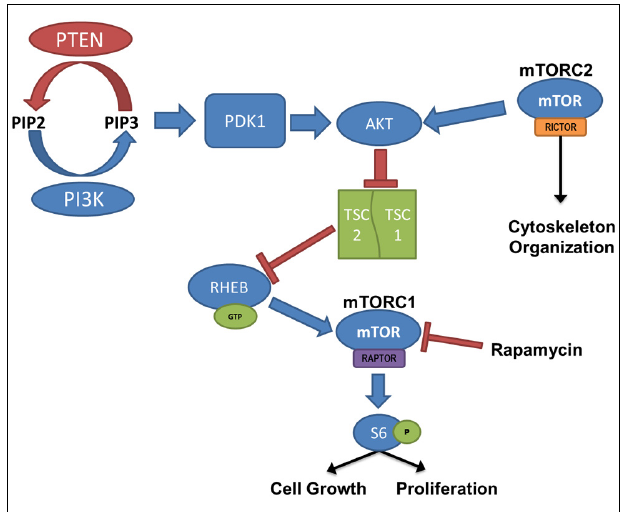
FIGURE 1 | PI3K/PTEN–mTOR pathway. mTOR is activated by signaling through the PI3K–Akt pathway, regulating cell growth and proliferation. PTEN,TSC1, andTSC2 act as negative regulators of the mTOR pathway, and removal leads to hyperactivation of mTOR. mTOR complex 1 (mTORC1) signaling requires activation of the adaptor protein raptor, and mTOR complex 2 (mTORC2), which is largely insensitive to acute rapamycin treatment, requires activation of the rictor protein. Although regulation of mTORC2 is less clearly defined, it has been linked to cytoskeleton